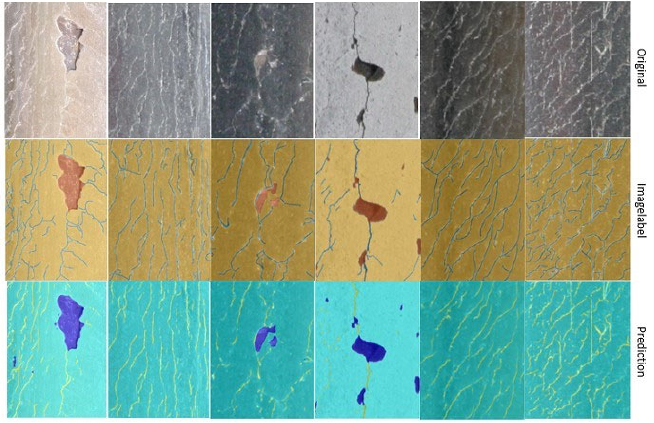
Figure 9. Semantic segmentation results.